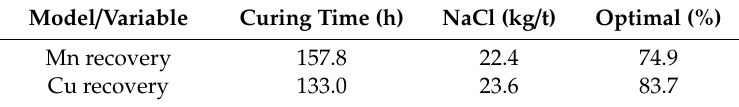
Figure 6. Settings and sensitivity for optimal solution for Cu recovery (%).